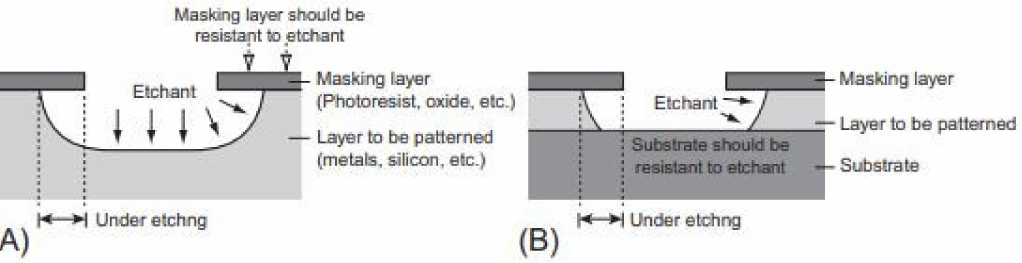
Figure 6. Wet etching (side view). ( A ) indicates a case where a substrate or a thick material is being etched, and ( B ) shows a case where a thin film deposited on a substrate is patterned [134]. (Adapted with permission from Ref. [134]. Copyright 2014 Elsevier).